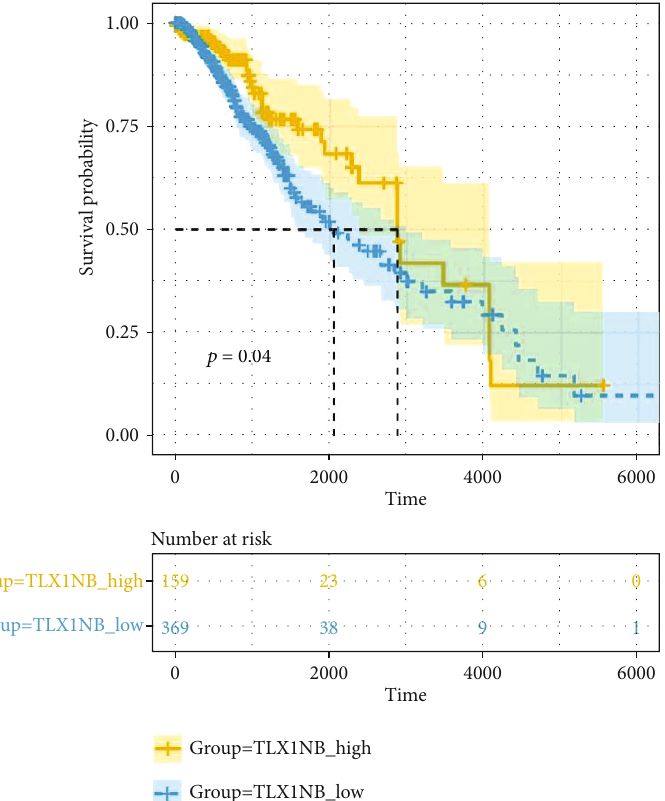
Figure 5: Overall survival plot for TLX1NB between the high and low groups in LGG. A p value < 0.05 was selected as the signi fi cance